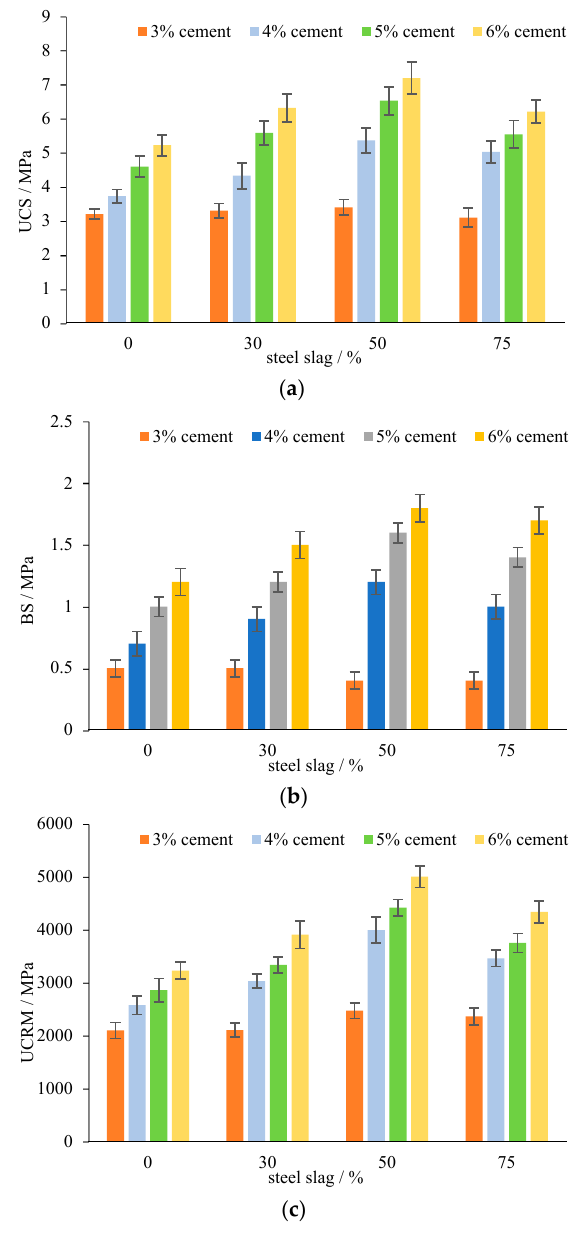
Figure 10. Mechanical properties of mixtures with steel slag. ( a ) UCS at 7 d; ( b ) BS at 28 d; ( c ) UCRM